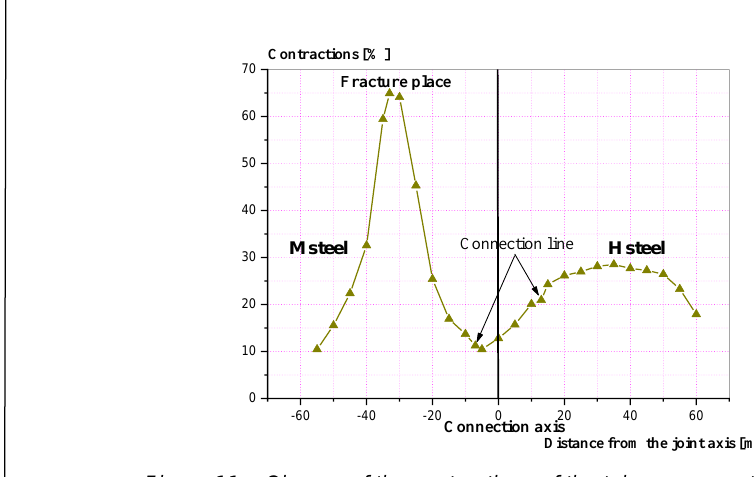
Figure 11 – Change of the contractions of the tube cross-section 2.1 Рис. 11 – Изменение сужений поперечного сечения эпроветки 2.1 Слика 11 – Промена контракција попречног пресека епрувете